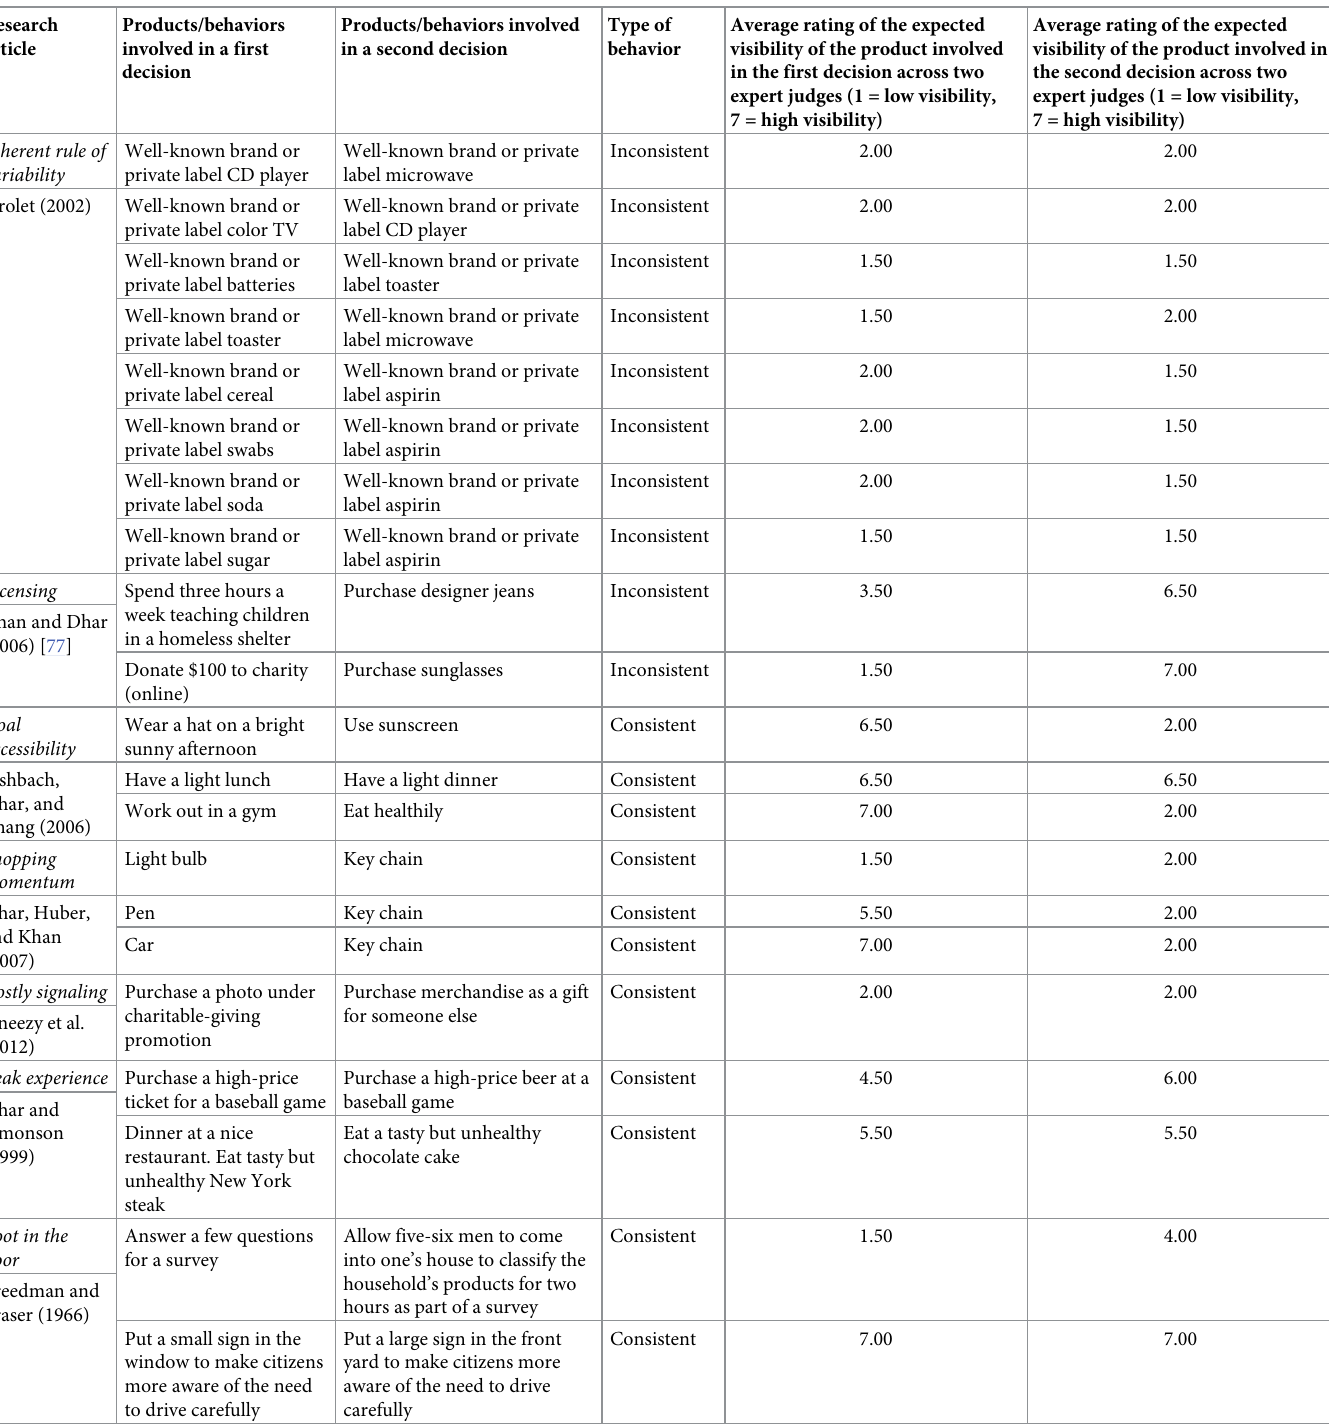
Table 3. Review of previous research: Products/behaviors used to examine consistency in sequential